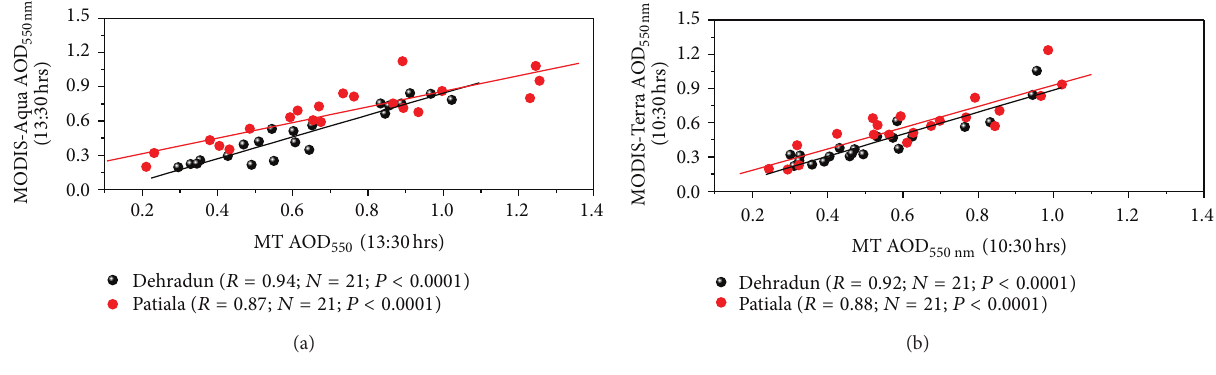
Figure 8: Correlation of MODIS Terra and MODIS Aqua AOD 550 overpass) over Dehradun and Patiala.